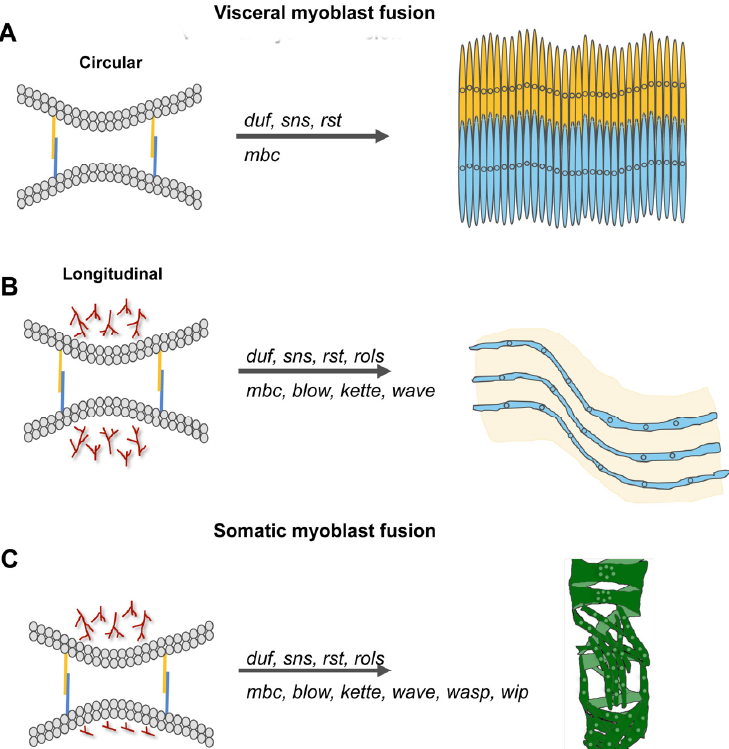
Figure 6. Molecular players of myoblast fusion increase with the complexity of the muscle that is formed. ( A , B ) Visceral muscles consist of binucleated circular muscle fibers that are interwoven with multinucleated longitudinal muscles. The fusion of founder cells and fusion-competent myoblasts during circular muscle formation is incomplete and depends on the cell adhesion molecules Duf, Rst, Sns, and the GEF Mbc. Longitudinal muscles contain up to six nuclei. The fusion of myoblasts is promoted by the presence of duf, rst, sns, mbc, blow, rols, and kette . ( C ) During somatic myoblast fusion, the fusion process is disturbed by the lack of duf, sns, rst, rols, mbc, blow, kette, wave, wasp, and wip